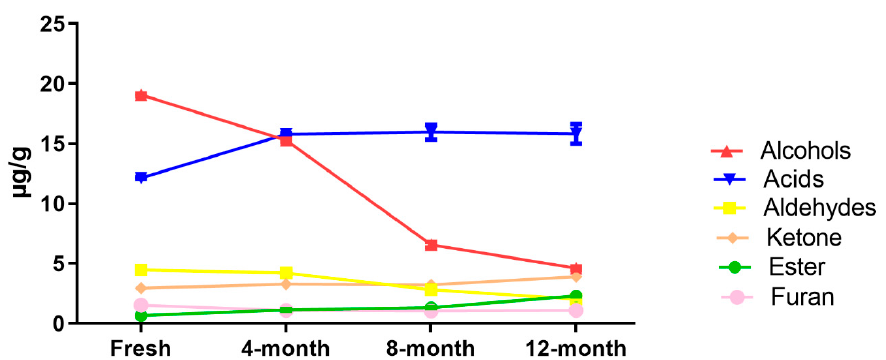
Figure 3. Post-storage changes of di ff erent classes of fatty acid-derived compounds in sun-dried raisins.